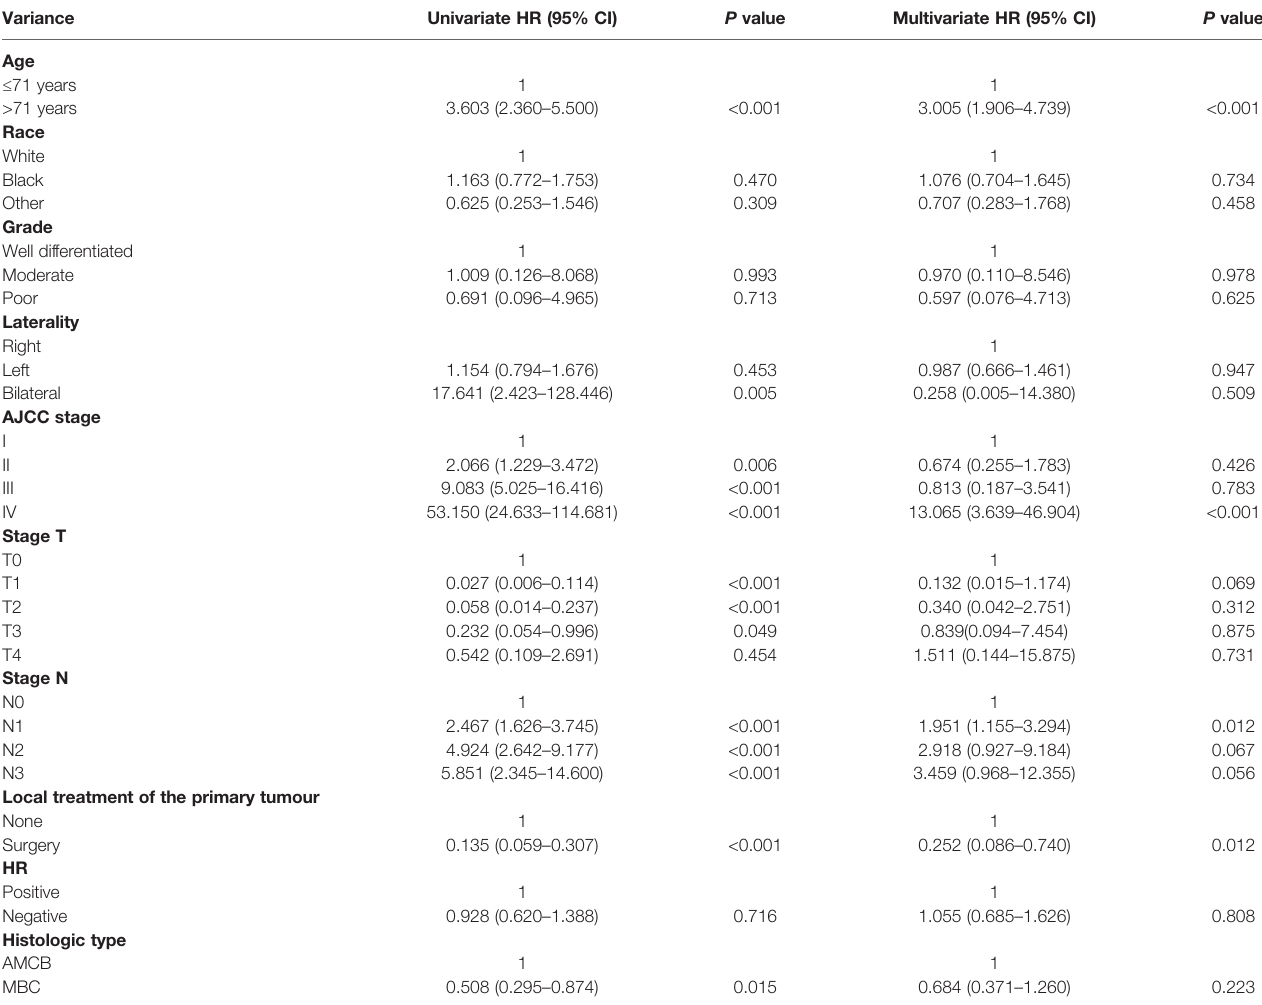
TABLE 2 | Univariate and multivariate Cox proportional hazard analyses of the association of clinical characteristics with overall survival rates in patients with AMCB and MBC.